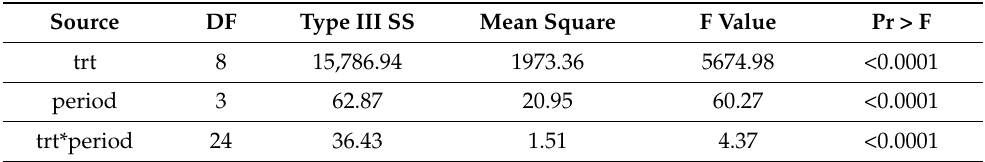
trt: cement type, period: immersion duration.